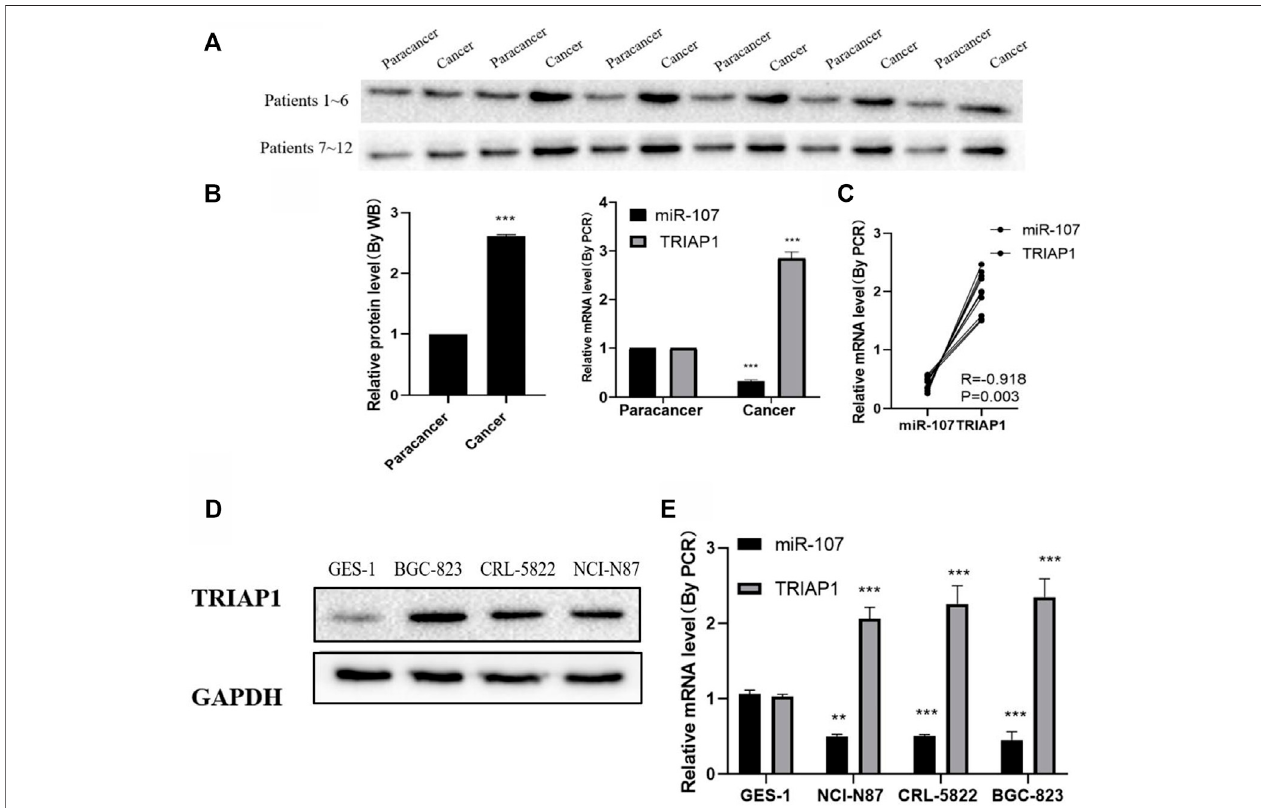
FIGURE 1 | miR-107 is down-regulated and TRIAP1 is up-regulated in GC tumors (A) Western blot analysis of TRIAP1 in cancerous and adjacent tissues of patients with gastric cancer, (B) Quantitative analysis of RT-PCR and Western blotting, (C) Correlation analysis of the expression levels of TRIAP1 and miR-107 in the tumor tissues of GC patients, (D) Western blot analysis of TRIAP1, (E) RT-PCR quantitative analysis of TRIAP1. The data are expressed as the mean ± SD of three experiments. and the data is analyzed by Student t or ANOVA test, * p ＜ 0.05, ** p ＜ 0.01, *** p ＜ 0.001.